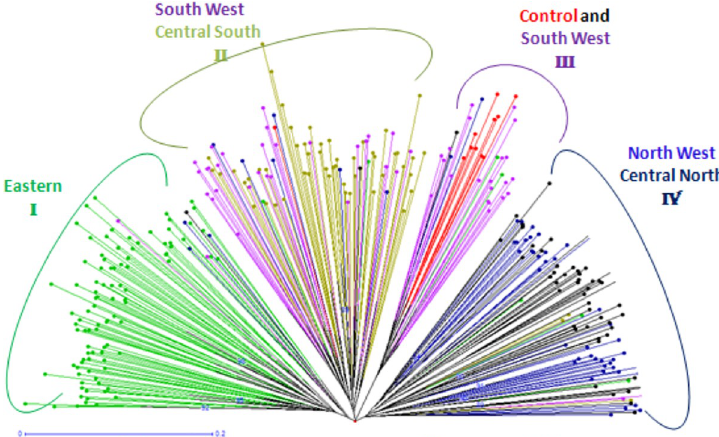
Fig 3. Neighbour-Joining tree of the clustering pattern among IC populations in